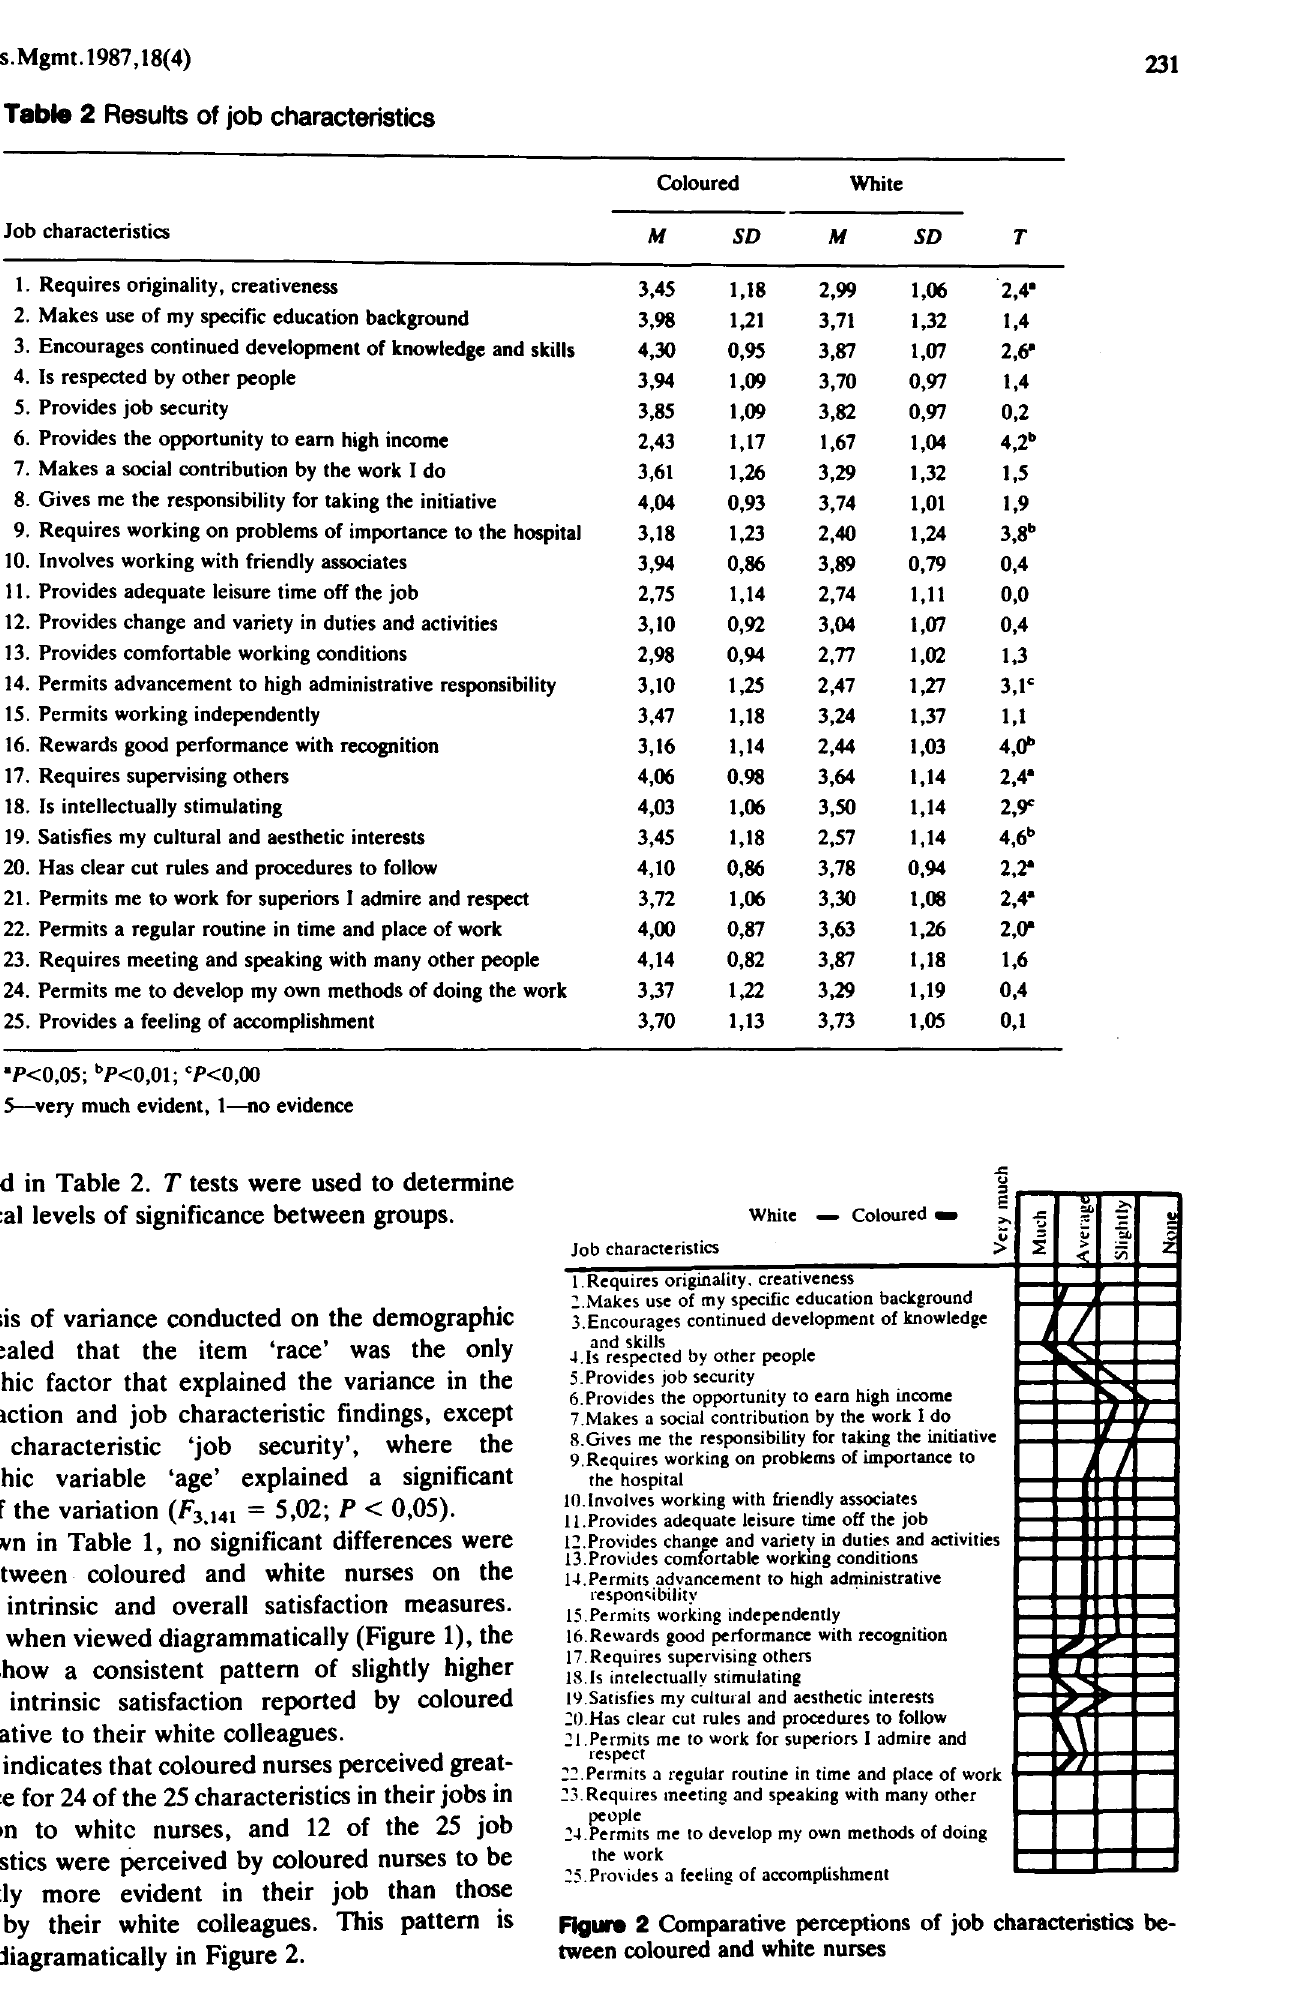
Table 2 Results of job characteristics